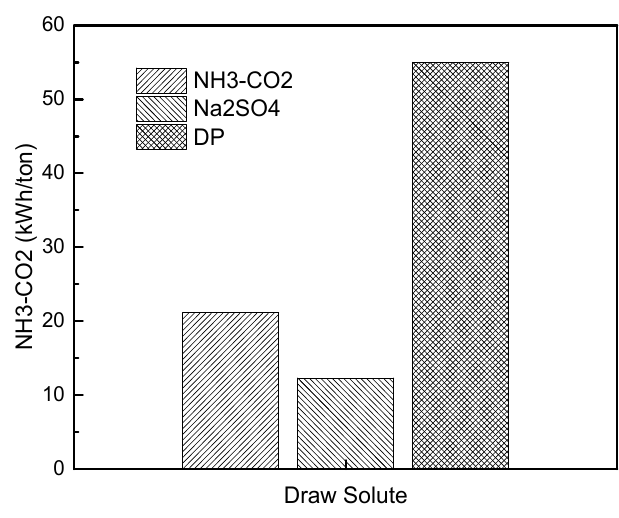
Figure 18. Equivalent work comparison of the FO process using different draw solutes.